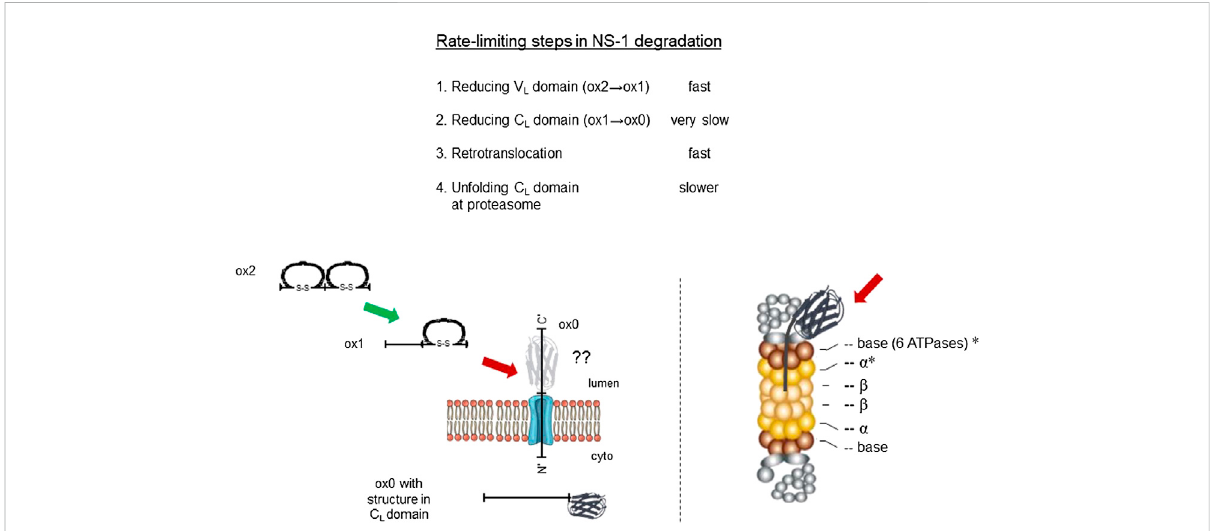
FIGURE 7 Identi fi cationofrate-limitingstepsinNS1degradation.Delineationofdegradationstepsrevealedinthisstudyandtheirrelativerateofexecution are shown at top. Schematic of steps in the reduction and retrotranslocation of NS1 on left, and the location of proteasomal subunits engaging the MG132-generated fragment are shown with asterisks on the right. Fast steps are indicated with a green arrow and slower ones with red arrows. The unknown conformation of the reduced C L domain as it passes through the retrotranslocon is portrayed in grey with a question